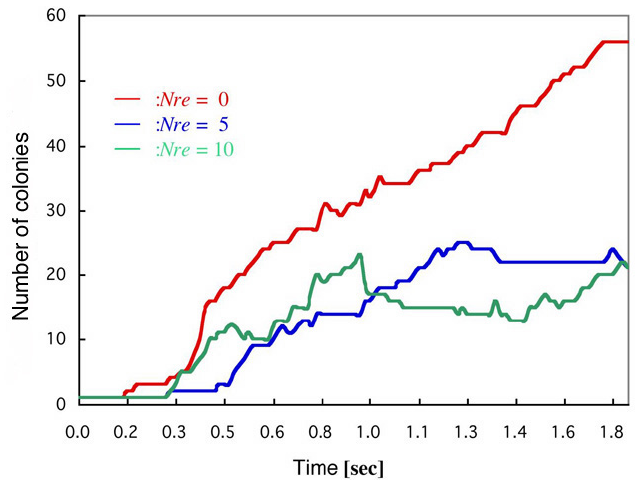
Fig. 6 Time course of number of colonies. One colony was defined as a cluster in which the gap between . In the case of N bind = 0, the number of colonies tends to neighboring particles | s | satisfied 0 | | L ε≤ s increase with respect to the time. In the cases of N bind = 5, and 10, the number of colonies much slowly changed as compared to the case of N bind = 0.